Question: What type of chart is this?
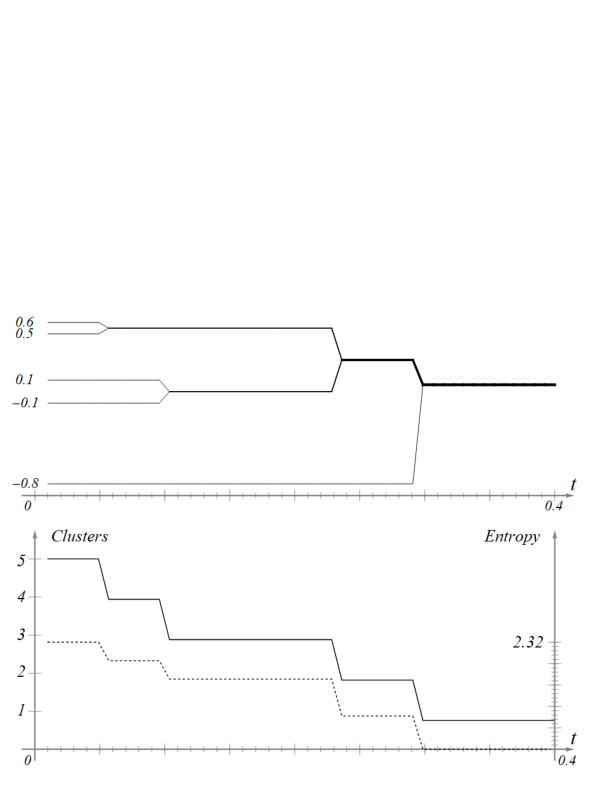
Answer: line